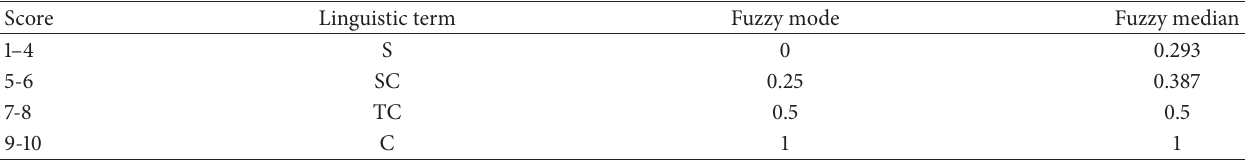
Table 2: Representative value for linguistic terms.